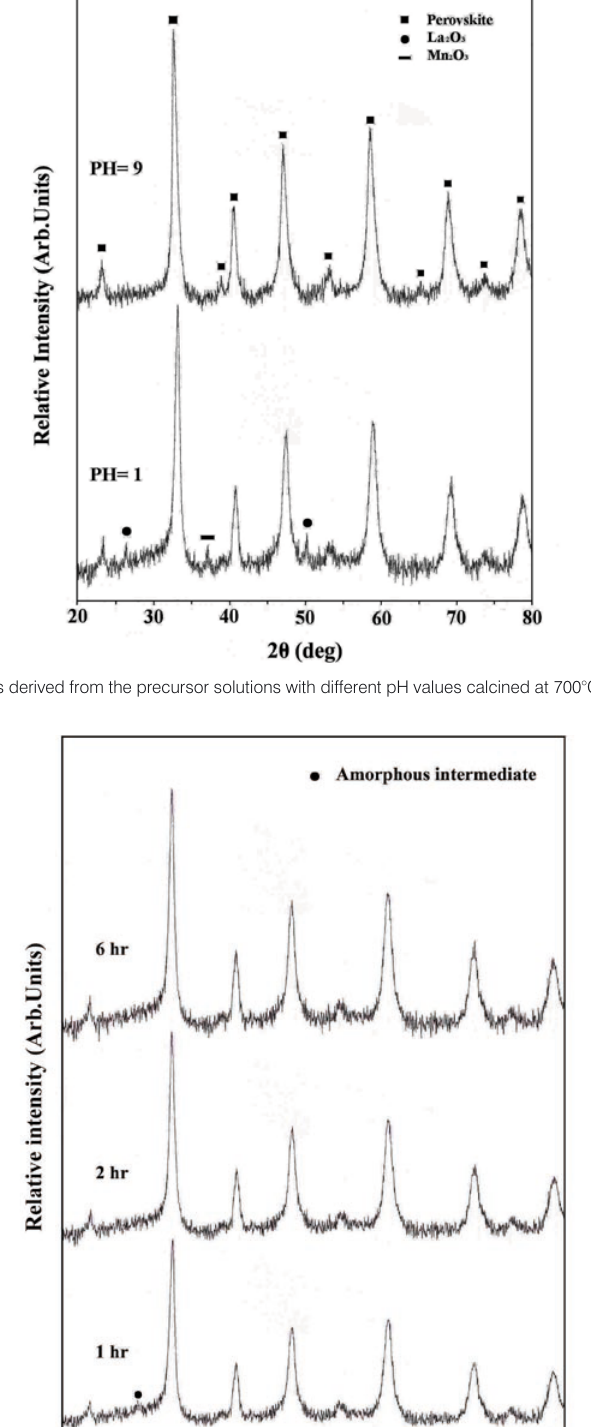
Ca MnO calcined at 520°C for various 0.6 0.4 3